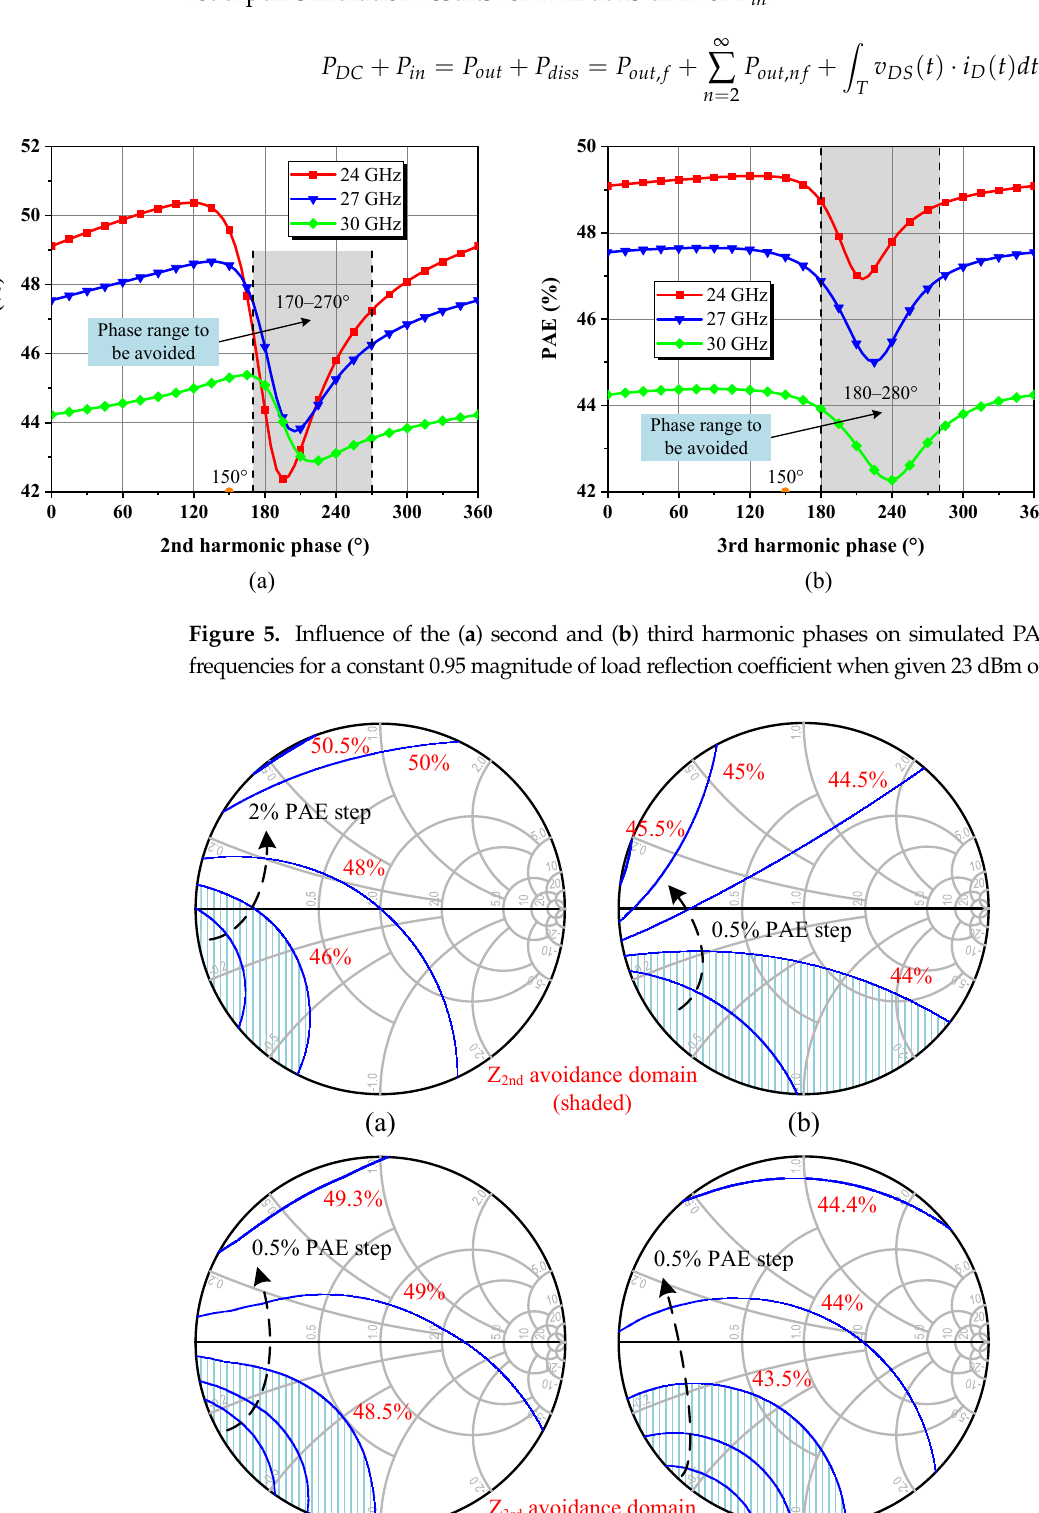
Figure 6. Harmonic load-pull simulation results: second harmonic at ( a ) 24 GHz and ( b ) 30 GHz; third harmonic at ( c ) 24 GHz and ( d ) 30 GHz.